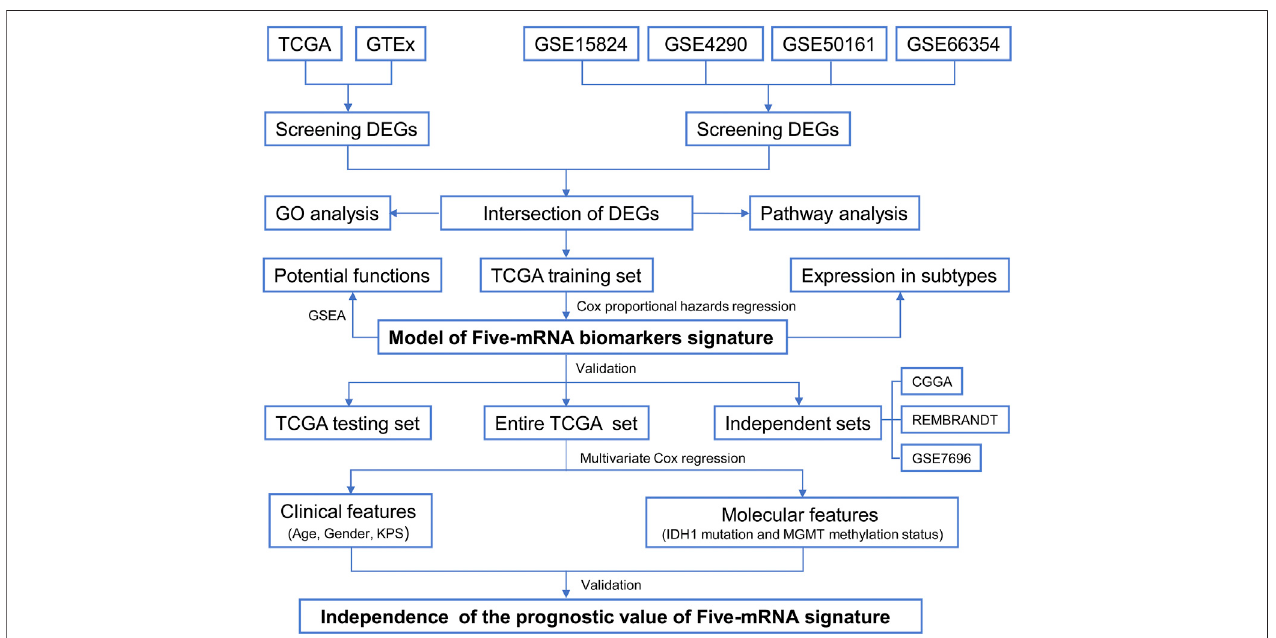
FIGURE 1 | Flow chart of the